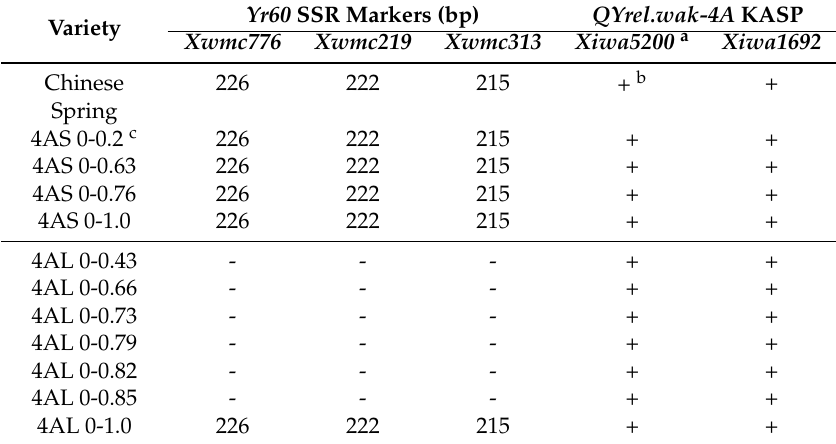
Table 5. Chinese Spring deletion lines for 4AL and 4AS were evaluated with SSR markers from Yr60 variety “Lalbahadur” and KASP markers for QYrel.wak-4A to determine the location of the two loci on the long arm of chromosome